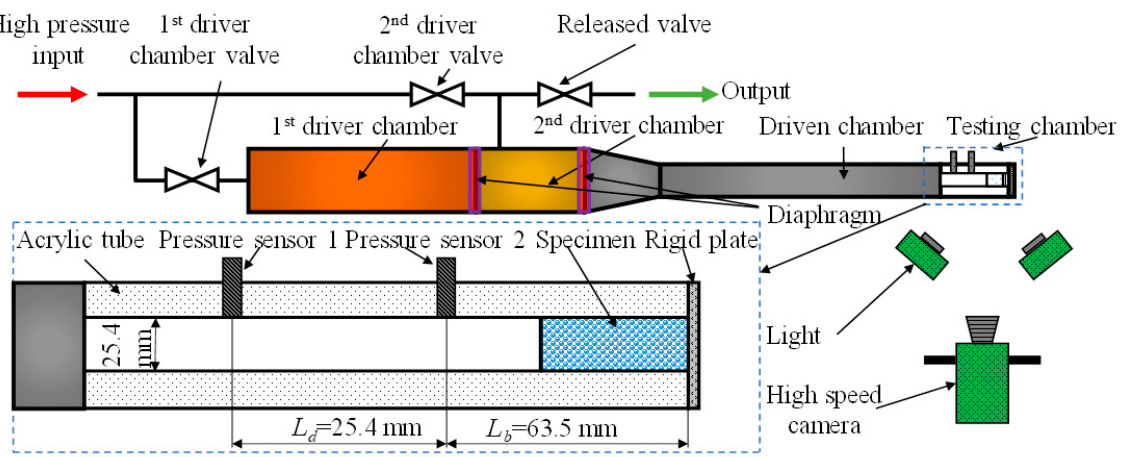
Figure 5. The shock tube experiment